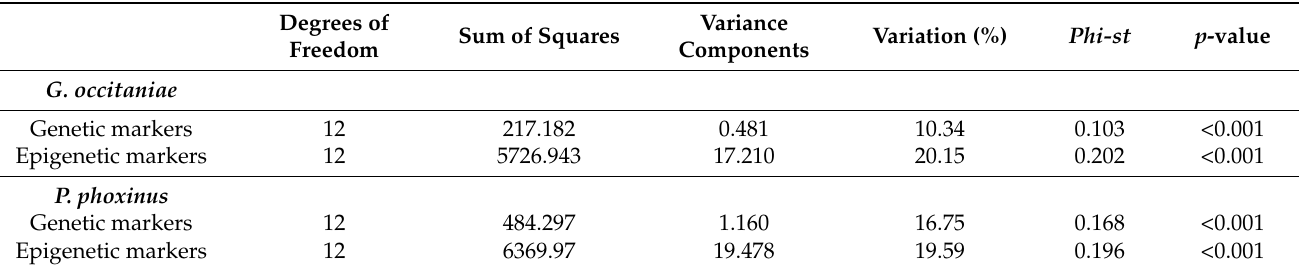
Table 2. Outputs of analyses of molecular variance (AMOVA) aiming at testing the part of the molecular variance that was explained by the between-population component (the within-population component is not shown here). Results are presented for the two fish species ( G. occitaniae and P. phoxinus ) and the two molecular marker types (genetic and epigenetic markers) separately. For the genetic marker, only microsatellite markers have been considered in this analysis (see the text for details). The percentages of the total variance (“Variation”) explained by the between-population component (and the associated Phi-st values) are presented, as well as the respective p -values based on permutation tests with 1000 repetitions. Degrees of Sum of Squares Freedom